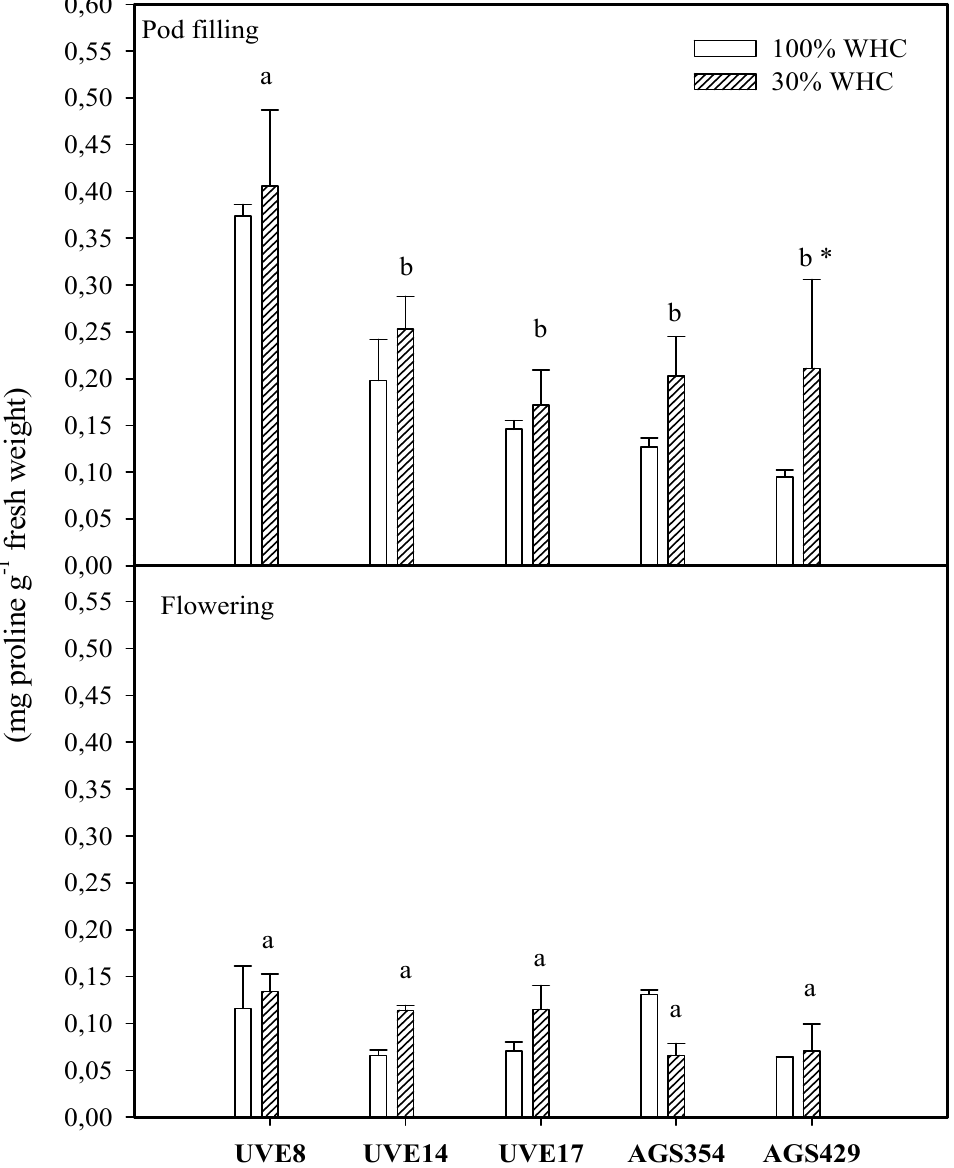
Figure 1. Proline content for five vegetable-type soybean cultivars subjected to two water treatments at flowering and pod filling stages. Values represent means ± SD ( n = 3). Letters represent significant differences/similarities in proline content for various cultivars under severe water stress at 30% water holding capacity (WHC), * represents significance at p ≤ 0.05.